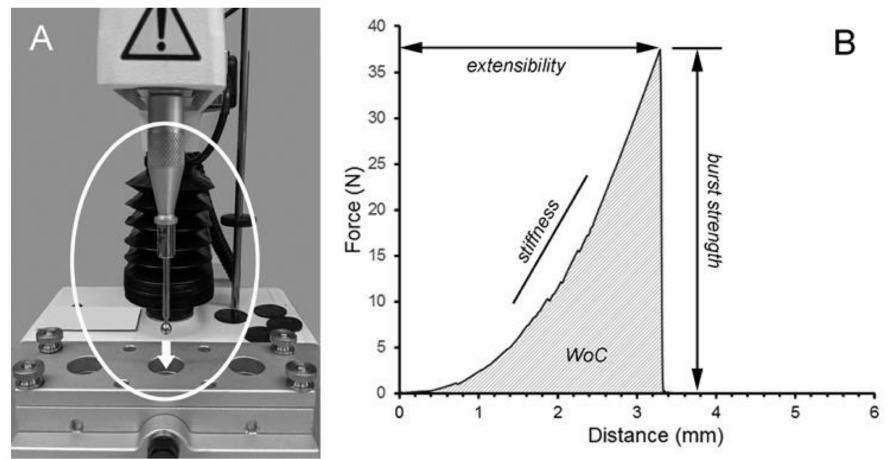
Figure 2. Burst strength of low-methoxyl pectin (LMP) films. ( A ) To test the cohesive properties of the LMP films, a uniaxial constant velocity was applied normal to the plane of the film until rupture. In these experiments, a 5 mm stainless steel probe was used to assess the burst strength, extensibility, sti ff ness, and work of cohesion (WoC) ( B ).